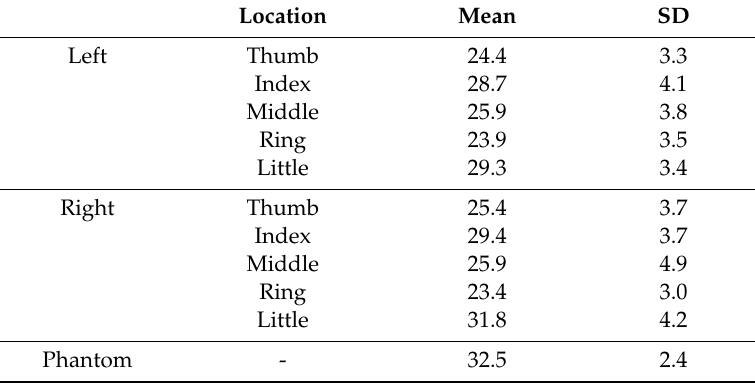
Table 1. Results comparing shore hardness at each fingertip and the value for the polydimethylsiloxane (PDMS) when mixed with 3% catalyst. A catalyst ratio below 3% was found to be unstable. Measurements taken with a shore 00 durometer.